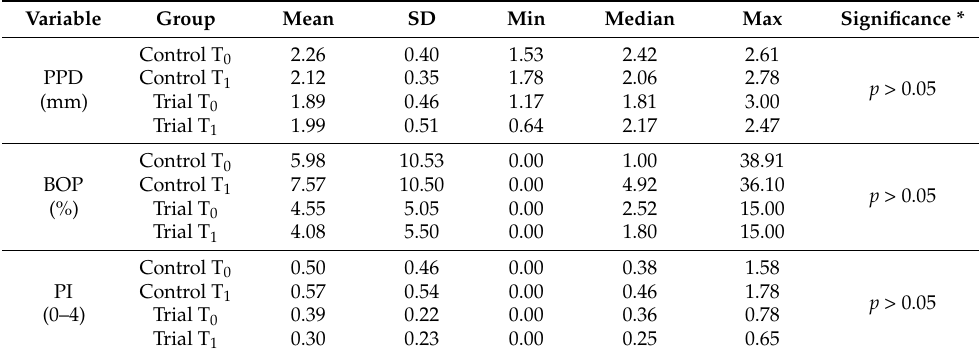
Table 3. Descriptive statistics of periodontal clinical